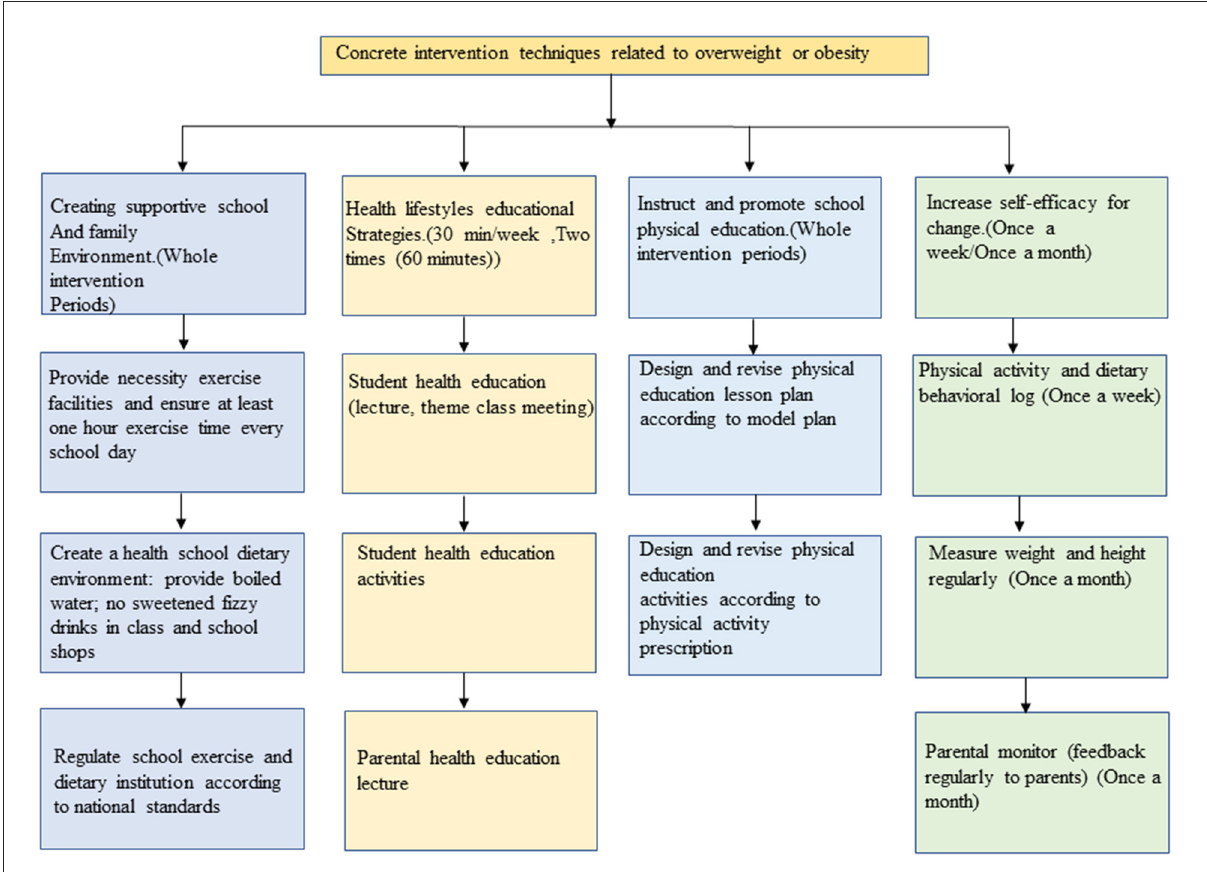
FIGURE2 The monitoring and instruction of obesity related